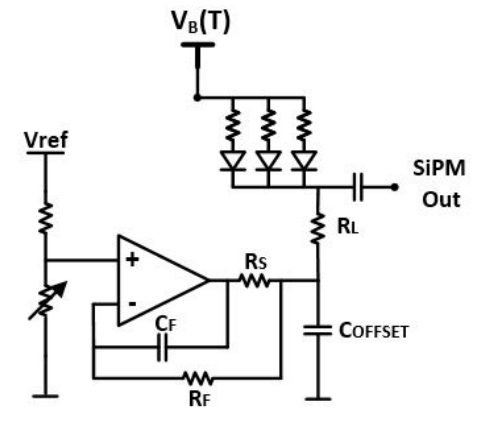
Fig. 5. Offset adjustment topology. The temperature-dependent bias voltage